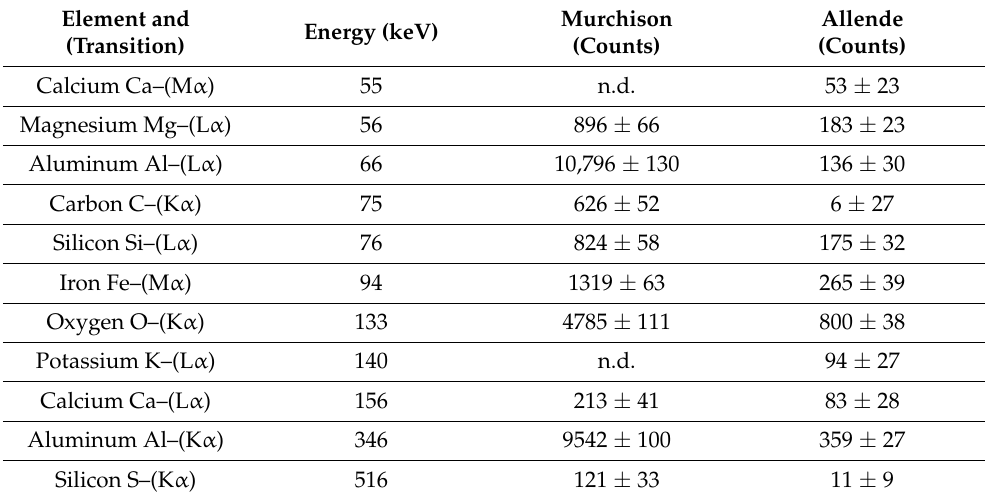
Table 3. The muonic X-rays detected (along with the transitions) in the Murchison and Allende meteorites and the concentrations of each element. The data was taken and adapted from Ref. [39]. Element and (Transition) Energy (keV)